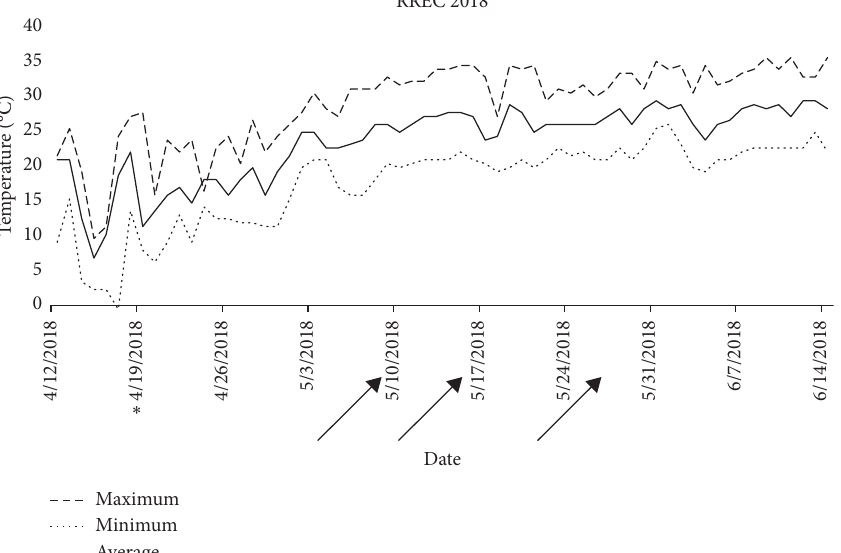
Figure 2: Daily minimum, maximum, and average temperatures at the Rice Research and Extension Center (RREC) in Stuttgart, AR, in 2018 for dates ranging from 7 days before planting to 14 days after the last application for the florpyrauxifen-benzyl and imazethapyr experiment. Rice cultivars CL111, CL272, and CLXL745 were planted on April 19, 2018. The 1-leaf (lf) application was made on May 11, the 3-lf application was made on May 16, and the 5-lf application was made on May 28. Planting date is indicated by ( ∗ ) and application dates are indicted by an